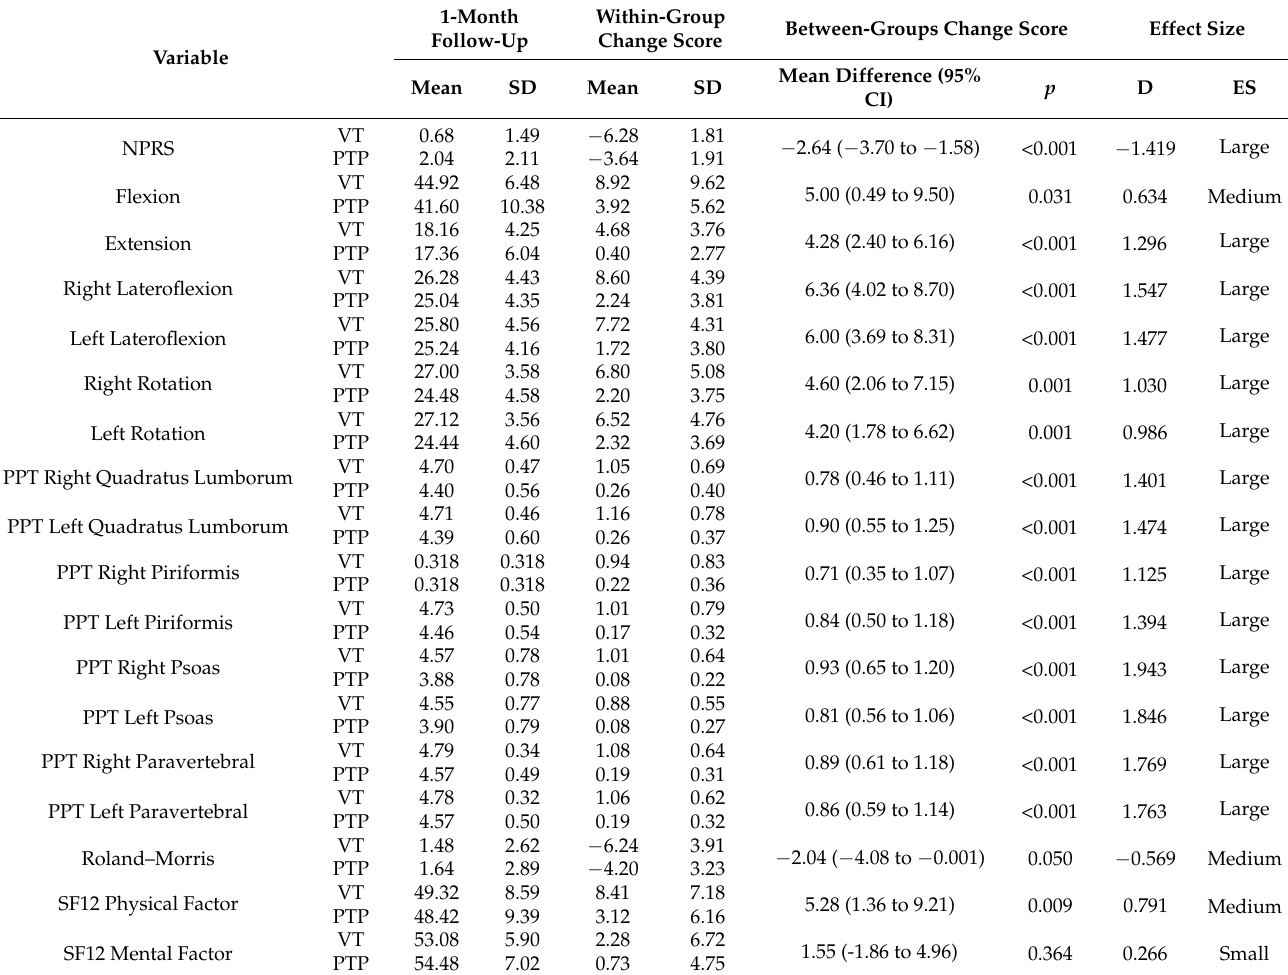
Table 4. Within-groups and between-groups differences at 1-month